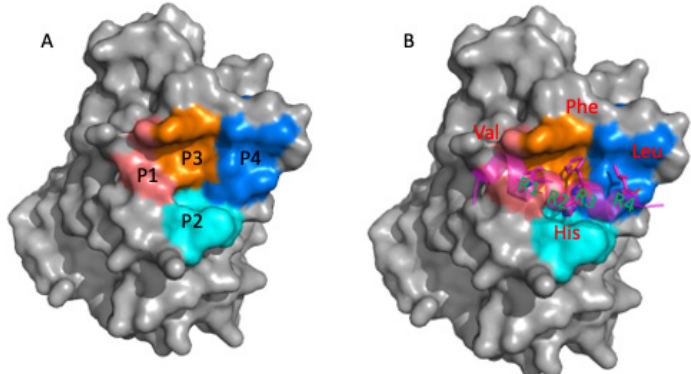
Figure 3. TEAD hotspots on interface 2. ( A ) Representation of the P1-P4 pockets in the binding groove of TEAD; ( B ) The mVGLL1-TEAD (PDB: 5Z2Q) complex. The interface 2, α -helix, peptide is represented in the transparent magenta ribbon. The mVGLL1 R1-R4 residues are shown as magenta sticks.